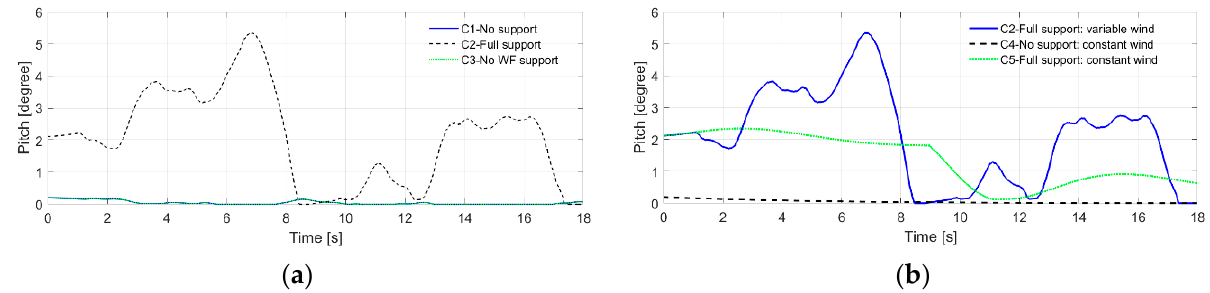
Figure 15. Pitch angle: ( a ) variable wind speed; ( b ) constant wind speed compared to Case 2.